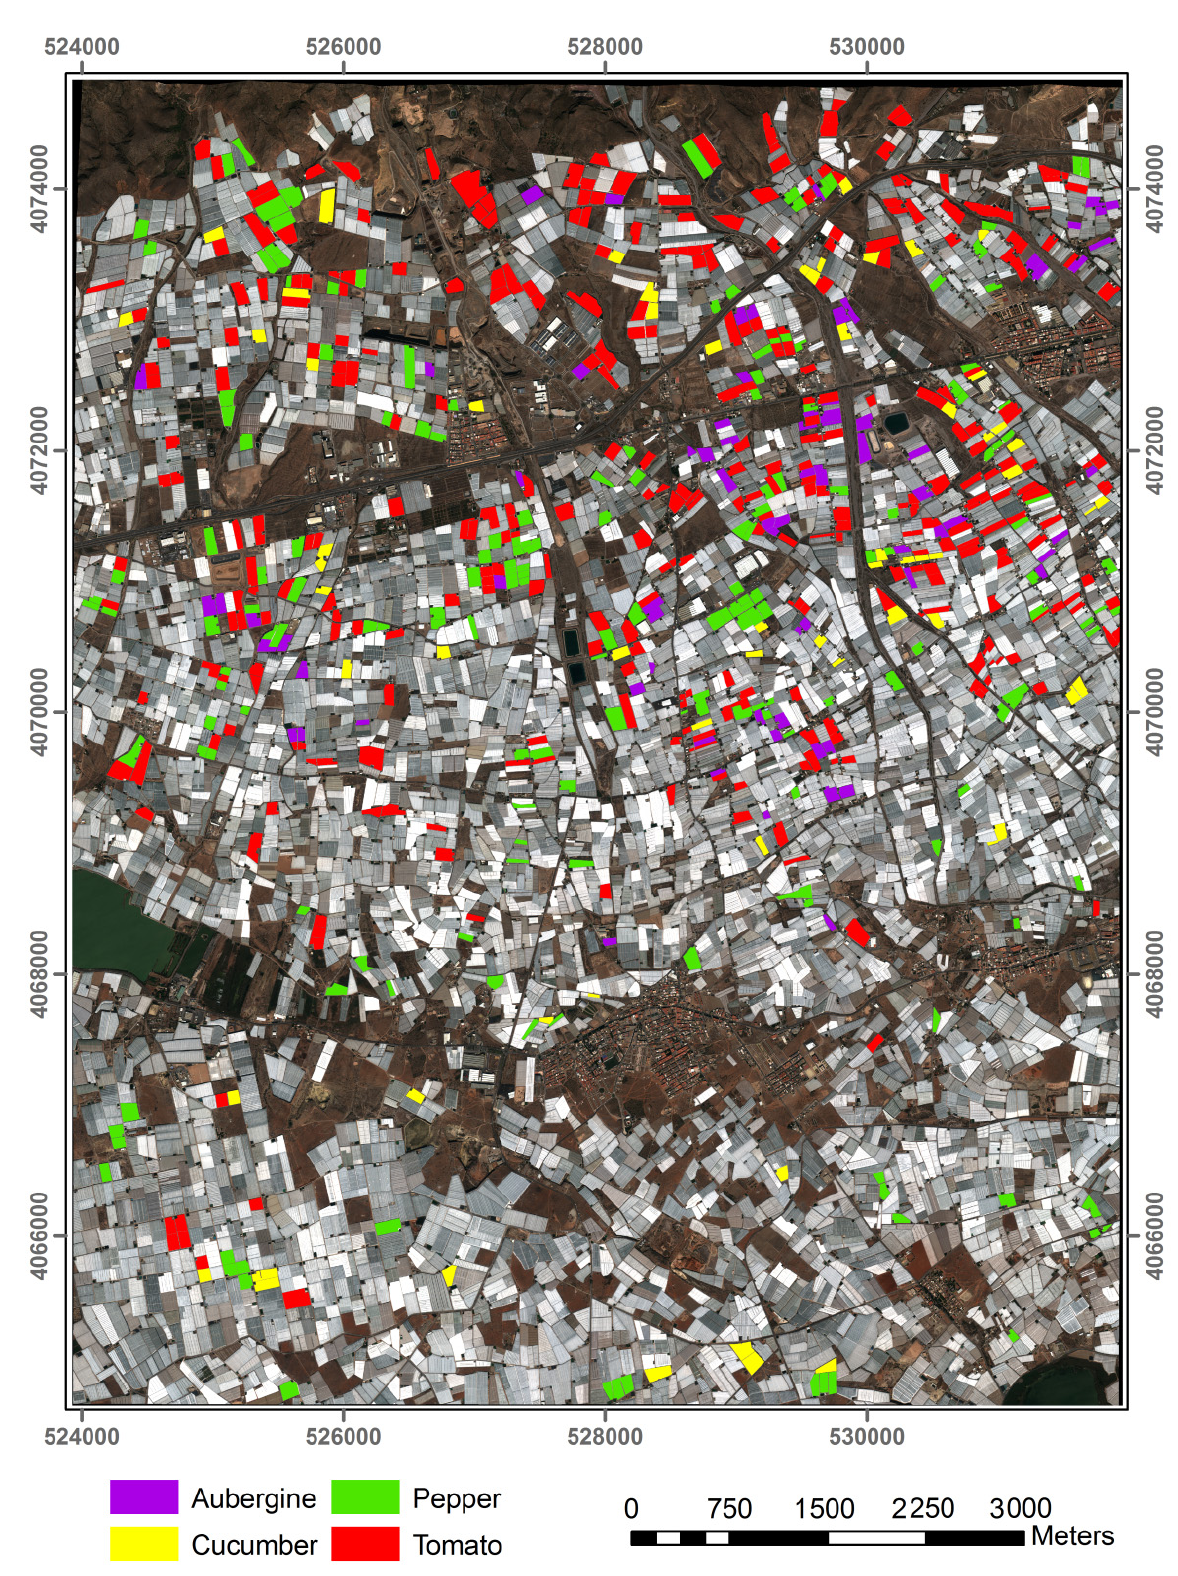
Figure 2. Location of the 694 reference greenhouses on the WorldView-2 (WV2) orthoimage and existing crops in autumn 2013. Coordinate system: ETRS89 UTM Zone